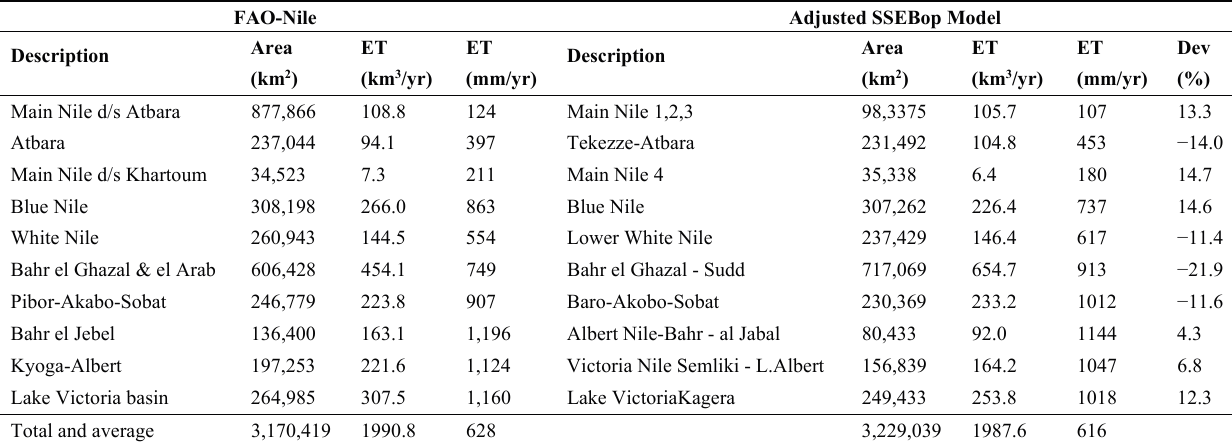
Table 3. Comparison of longer term ET volumes (km 3 /yr) and fluxes (mm/yr) estimated by FAO-Nile (1960–1990) and the adjusted USGS EROS SSEBop model (2005–2010). The deviation is based on the ET flux